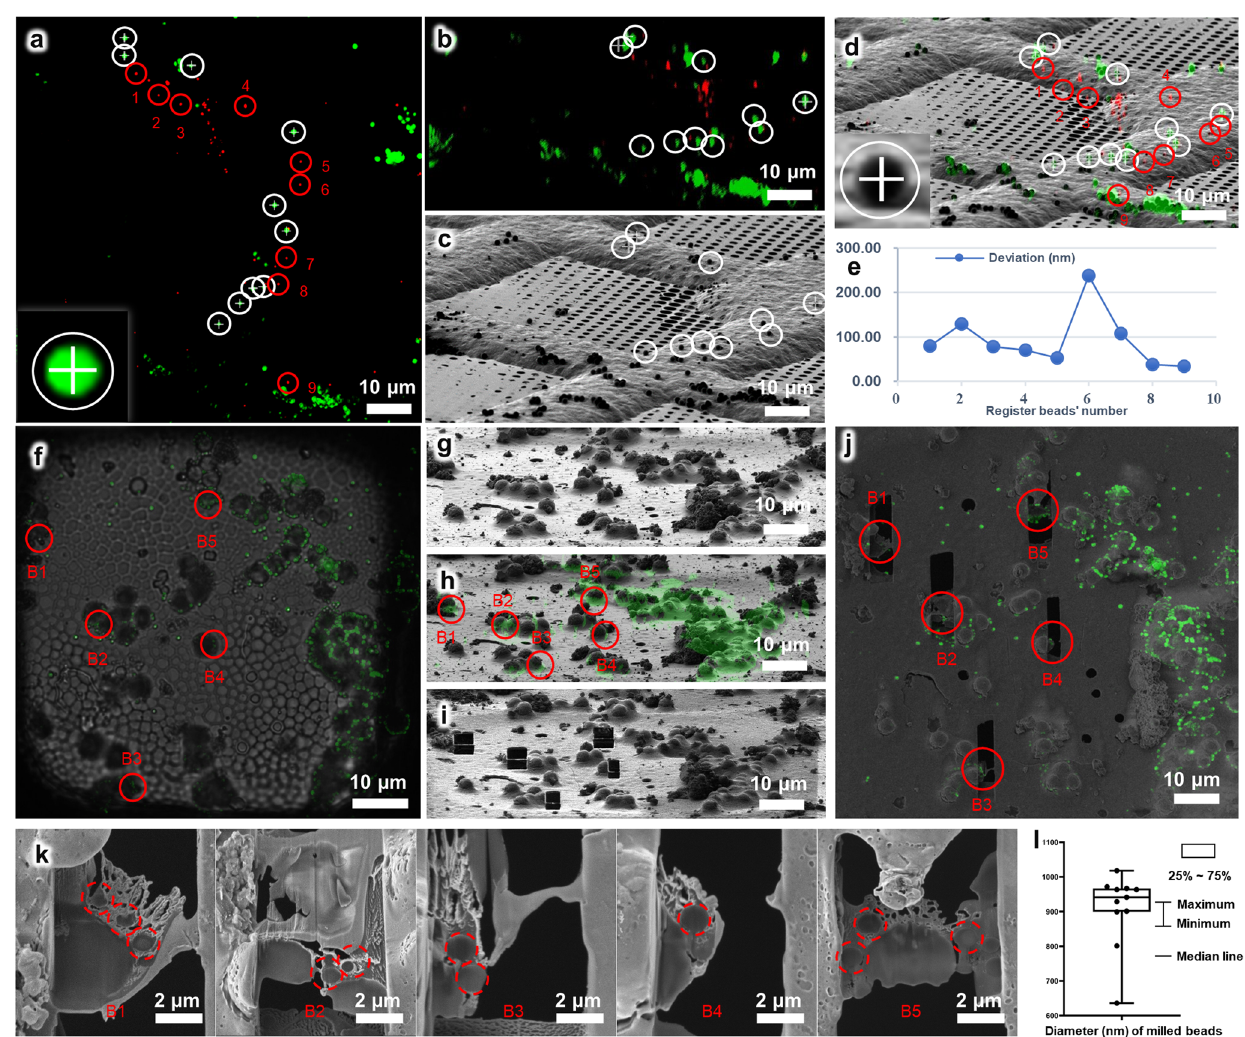
Fig. 3 Correlation accuracy of the HOPE-SIM system. a HOPE-SIM images of dried 0.5 μ m green and 0.2 μ m red fl uorescent microspheres spread on a GraFuture RGO grid. The green microspheres tagged by white circles and crosses are used as the fi ducial register markers. The red microspheres labeled from 1 to 9 are used to measure the correlation accuracy with the FIB image. b The projection of the HOPE-SIM image after 3D correlation with the FIB image. Microspheres corresponding to the green microspheres in ( a ) are tagged by white circles and crosses. c FIB image. Microspheres corresponding to the microspheres in ( a) and ( b ) are tagged by white circles and crosses accordingly. d 3D correlation between HOPE-SIM and FIB images. Microspheres tagged with red circles and labeled from 1 to 9 correspond to the red microspheres in ( a ), respectively. e Corresponding position deviations of the nine red microspheres between ( a ) and ( d ), respectively. f HOPE-SIM image of a vitri fi ed solution of fl uorescent blue microspheres (green channel) mixed with polymethyl methacrylate beads that were dropped directly on the EM grid. The fl uorescence image (green color) is merged with the bright- fi eld image. Five microspheres shielded by polymethyl methacrylate beads are selected as targets and named as B1-5. g Cryo-FIB image at the target region. h Cryo-CLEM image at the region in ( g ). The selected microspheres in ( f ) are indicated accordingly. i Cryo-FIB fabrication of the target microspheres in ( h ). j After cryo- FIB fabrication, cryo-SEM image (SE signal) of the grid at the target region was captured and merged with the fl uorescent image in ( f ). k High magni fi ed cryo-SEM images (SE signal) of each lamella at the positions of B1-B5. The cross sections of both 1 μ m fl uorescent microspheres and bigger polymethyl methacrylate beads are clearly resolved. And the diameters of the cross sections of fl uorescent microspheres can be measured directly from the SEM images and the resulted statistical distribution of the diameters is plotted in ( l ). See Supplementary Data 5 for raw cryo-FIB images of ( g ), ( h ), and ( j